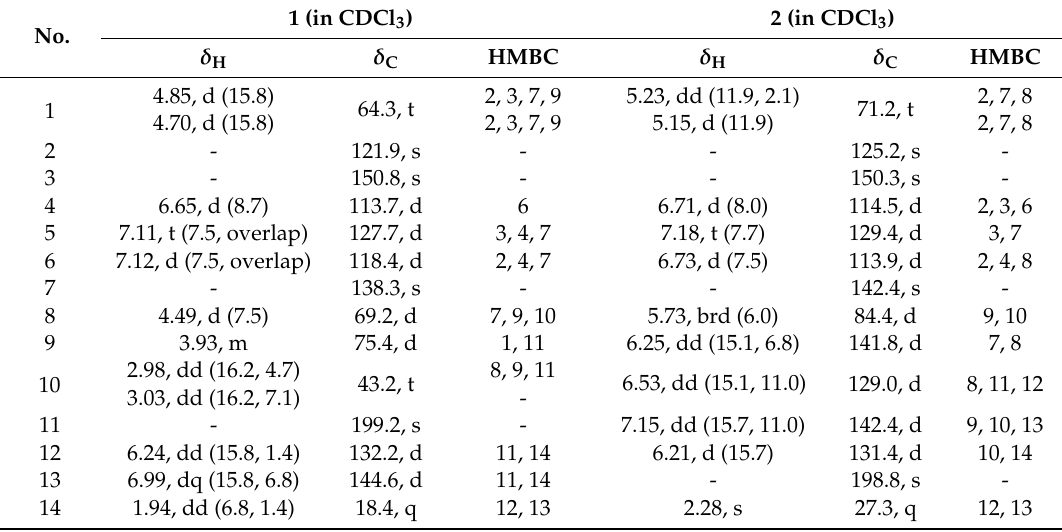
Table 1. 1 H and 13 C NMR Data of Compounds 1 and 2 ( δ in ppm, J in